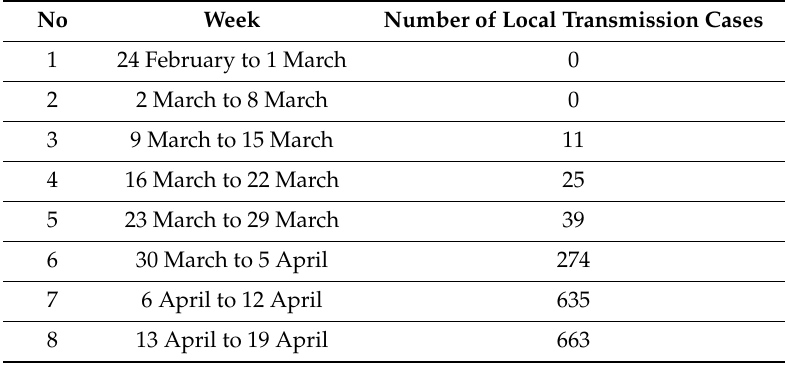
Table 8. Number local transmission cases from 24 February 2020 to 19 April 2020 by